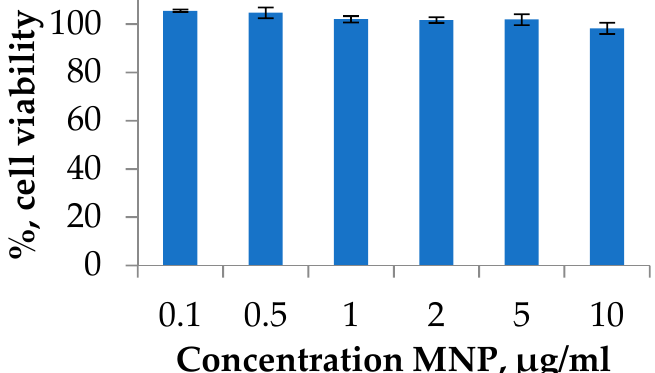
Figure 4. Cell viability studies of MNPs using MTT test. A549 cell line was incubated for 72 h with MNPs loaded at various concentrations. Cells treated with PBS buffer were used as a 100% viability control.